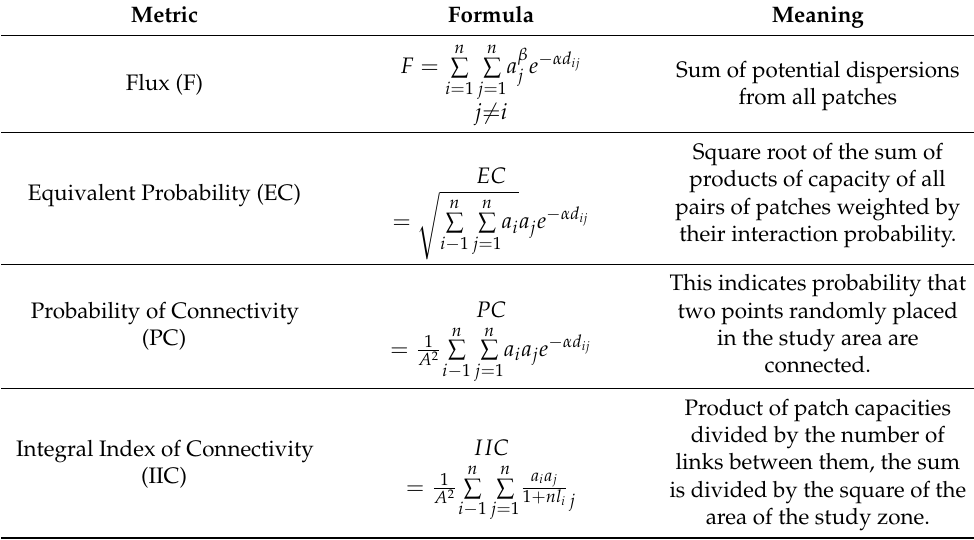
Table 1. Weighted global connectivity metrics used to measure connectivity in two